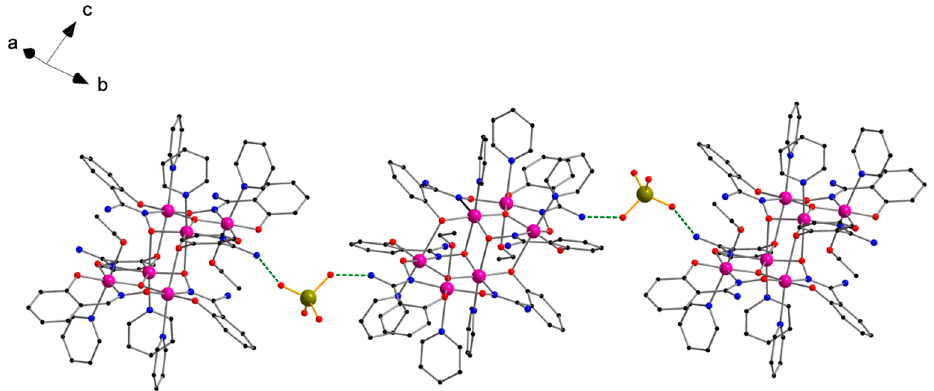
Figure 2. Perspective view of the one-dimensional arrangement of [Mn 6 ( μ 3 -O) 2 (H 2 N-sao) 6 (py) 6 (EtOH) 2 ] 2+ cations and [ReO 4 ] − anions in the crystal of compound 2 through H-bonding interactions (dashed lines). H atoms and solvent molecules have been omitted for clarity. Color code: Pink, Mn; red, O; blue, N; black, C; green, Re.